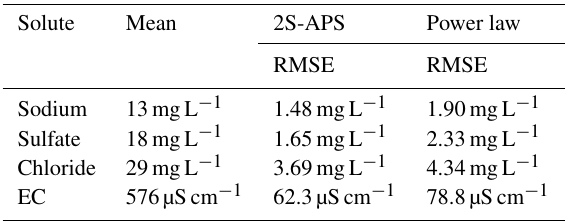
Table 8. Summary of values of RMSE criterion calculated for the three ions and EC with the validation